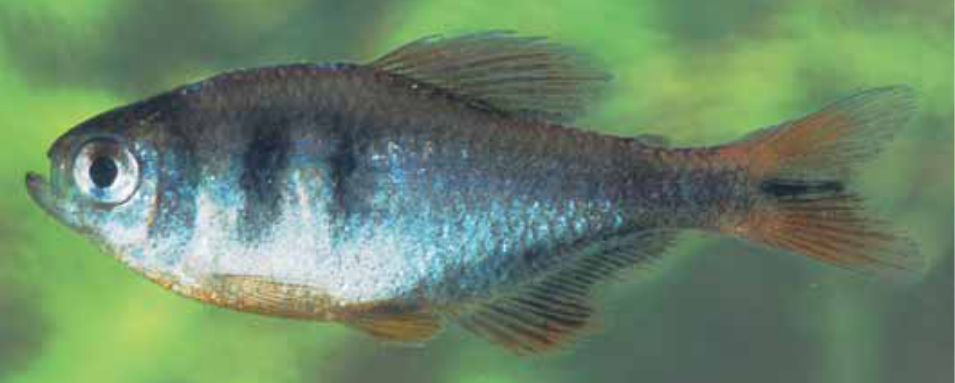
Fig. 10. Paratype of Hyphessobrycon weitzmanorum , MZUSP 73314, 21.5 mm SL, Brazil, Mato Grosso, município de Alto Araguaia, córrego Mosquito. Photographed in